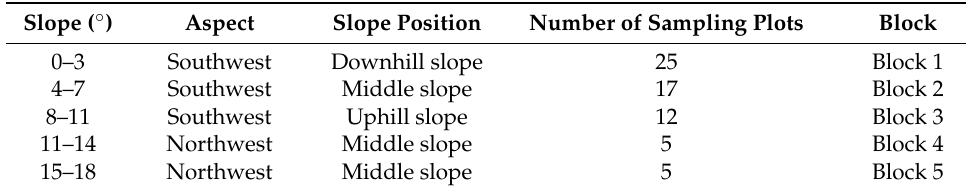
Table 1. Block division and plot